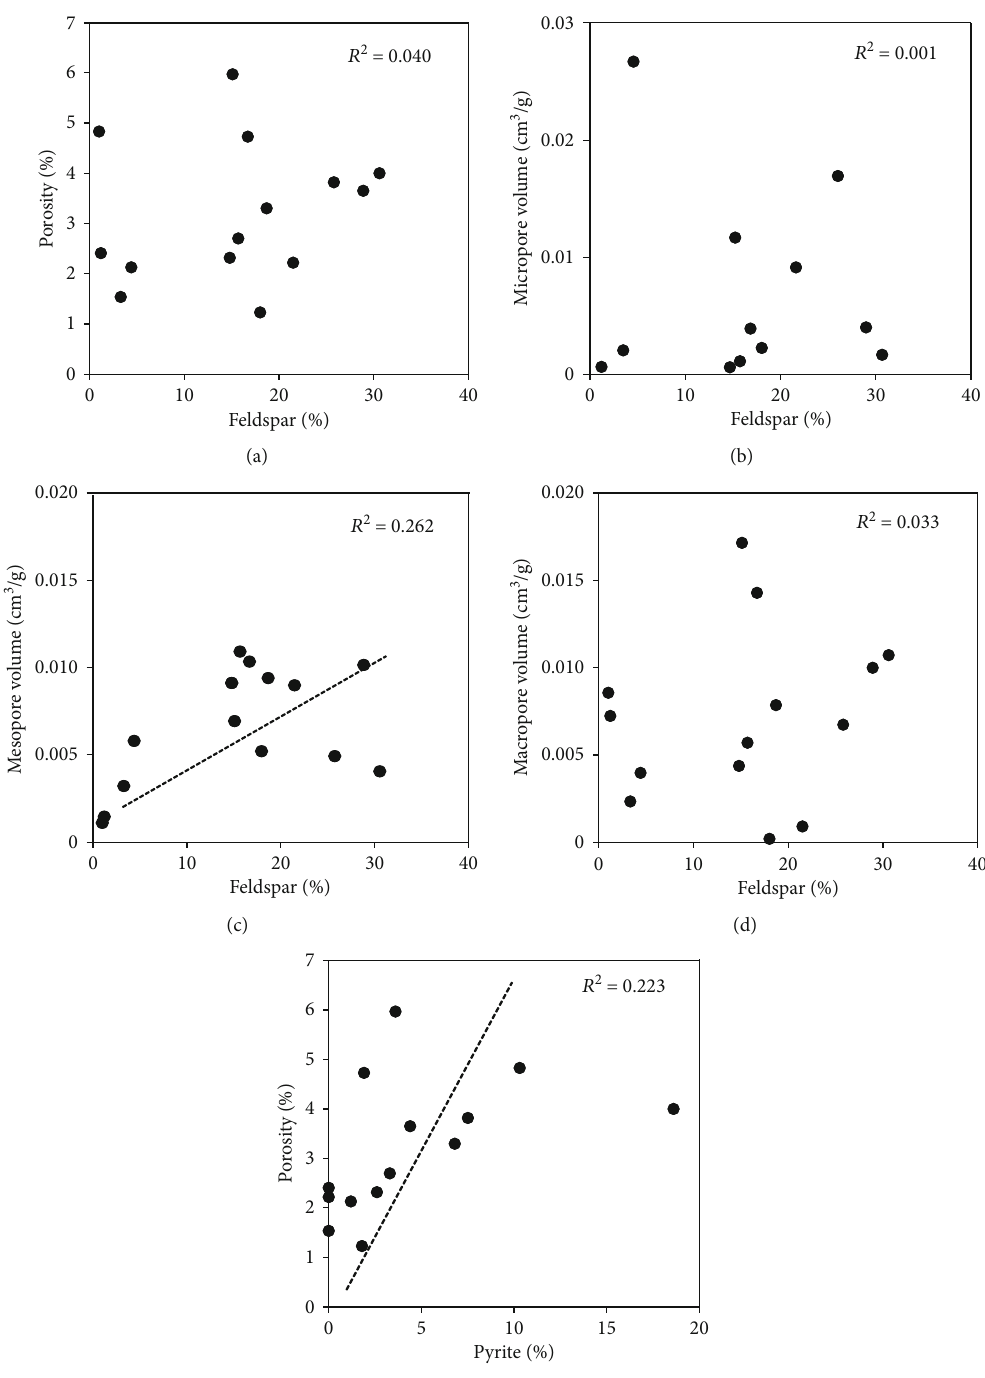
Figure 10: Correlation of rock mineral (quartz, clay, and carbonate) with porosity, volumes of micropores, mesopores, and macropores for shale